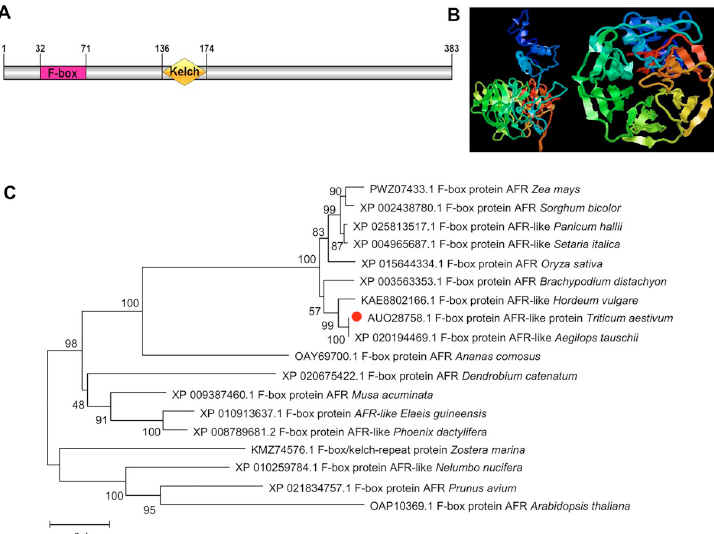
Fig 4. Sequence characteristics of wheat TaAFR. (A) Functional domain of TaAFR. A schematic diagram showing the positions of the F-box and Kelch domains in TaAFR; (B) 3D structure prediction of the TaAFR protein. The ribbons represent the α -helix structures, while the arrows denote the β -sheets. The colors highlight the position within the primary structure, with blue and red at the N- and the C-terminus, respectively; (C) Phylogenetic analysis of TaAFR with F-box proteins from different plants species. The phylogenetic tree was generated using the neighbour- joining method in MEGA 7. Branches are labeled with the GenBank accession number followed by species name.